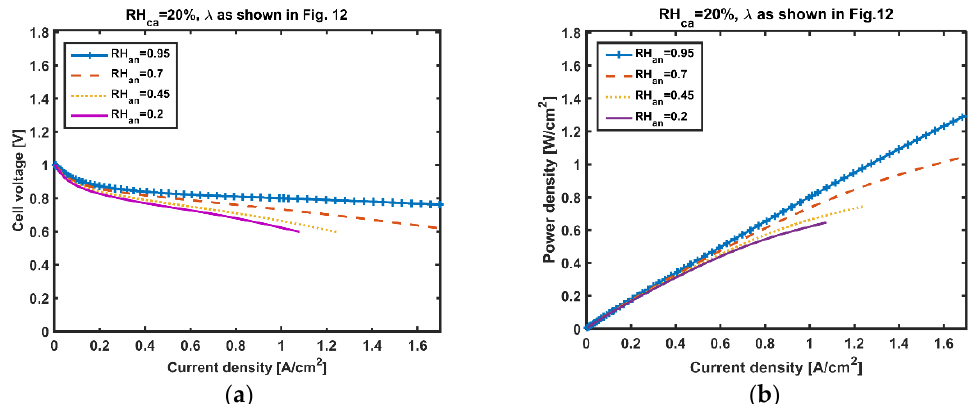
Figure 13. Voltage and power information of fuel cell at RH ca = 20%: ( a ) fuel cell voltage at different relative humidity of anode; ( b ) fuel cell power density at different relative humidity of anode.